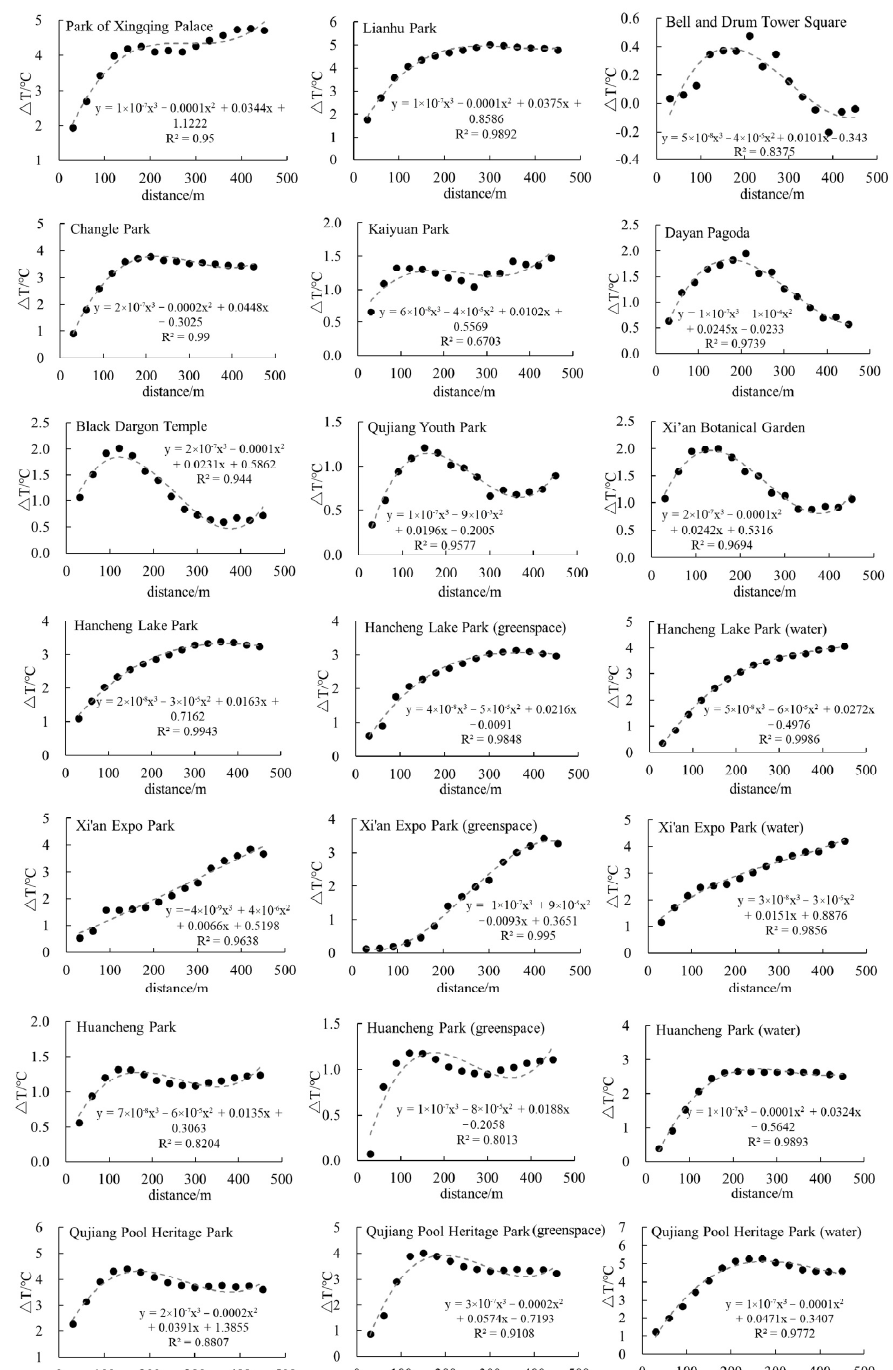
Figure 5. Relationship between Δ T of different buffers and distance from parks.